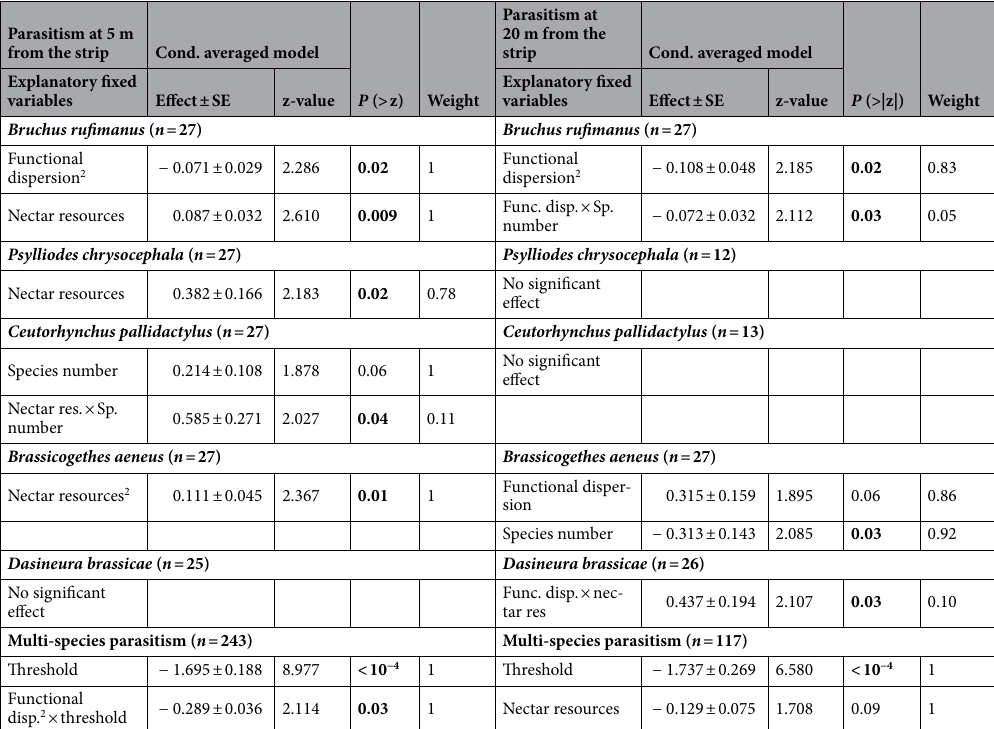
Table 1. Effects of the composition and structure (proportion of plant cover providing accessible nectar, species richness and functional dispersion) of the flower strip plant communities on the rates of parasitism in five herbivorous crop pests and on global multi-species parasitism (quantified via a multi-threshold approach). Significant P-values are written in bold. All possible combinations of the plant community variables (nectar resources, species richness and functional diversity, with both linear and quadratic effects) and their interactions were compared. The best models were ranked according to their AIC (Supplementary Table S5) and we present the results for the averaged best models. Generalized linear mixed effect models were used, assuming a binomial (parasitism rates) or Poisson (multi-species parasitism) distribution, with strip as a random effect. All explanatory variables were scaled. For readability, we report here the results for significant effects only or for variables with a relative importance (weight) greater than 0.70. The full results are provided in Supplementary Table S9. “n” is the number of observations for each response